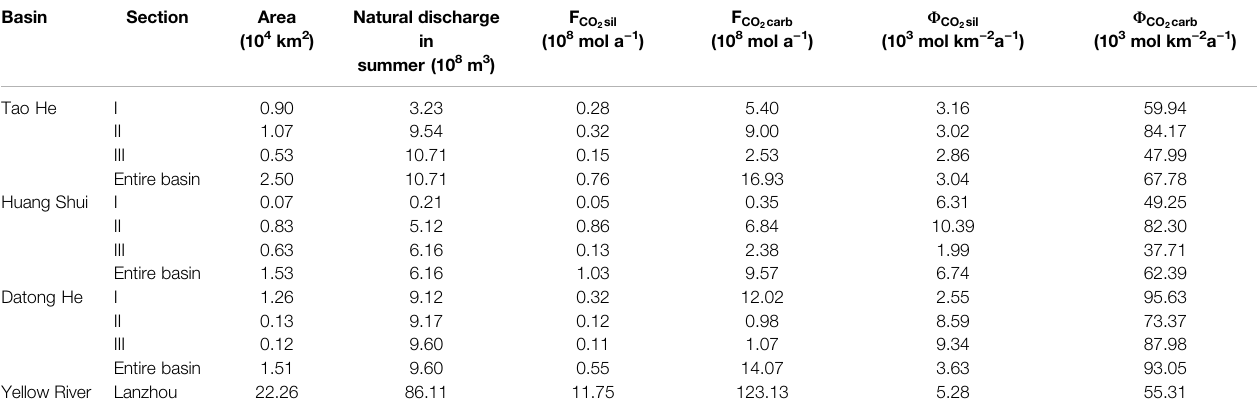
TABLE 3 | CO 2 consumption by chemical weathering of the Tao He, Huang Shui, Datong He, and the Lanzhou station on the Yellow River mainstream in summer (June to August). Basin Section